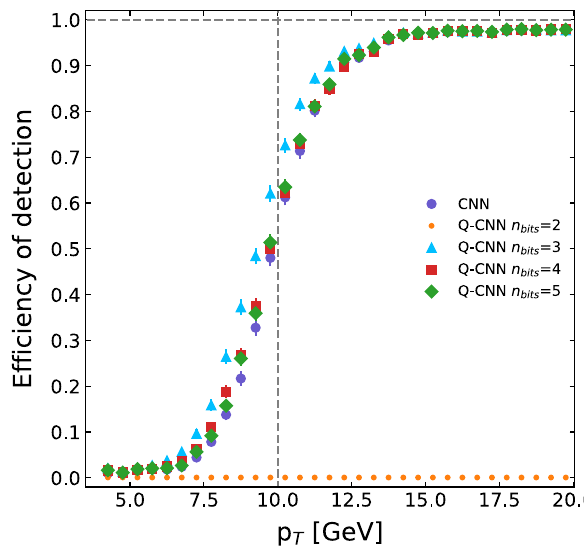
Fig. 8 Teacher efficiency curves (realized as for Fig. 6) for different levelsofquantization.Eachweightisafixedpointnumberwhominteger part is described using 0 bits and the decimal part using n bits . Statistical uncertainties computed as binomial confidence intervals are shown as well. If not visible, they’re smaller than the markers size